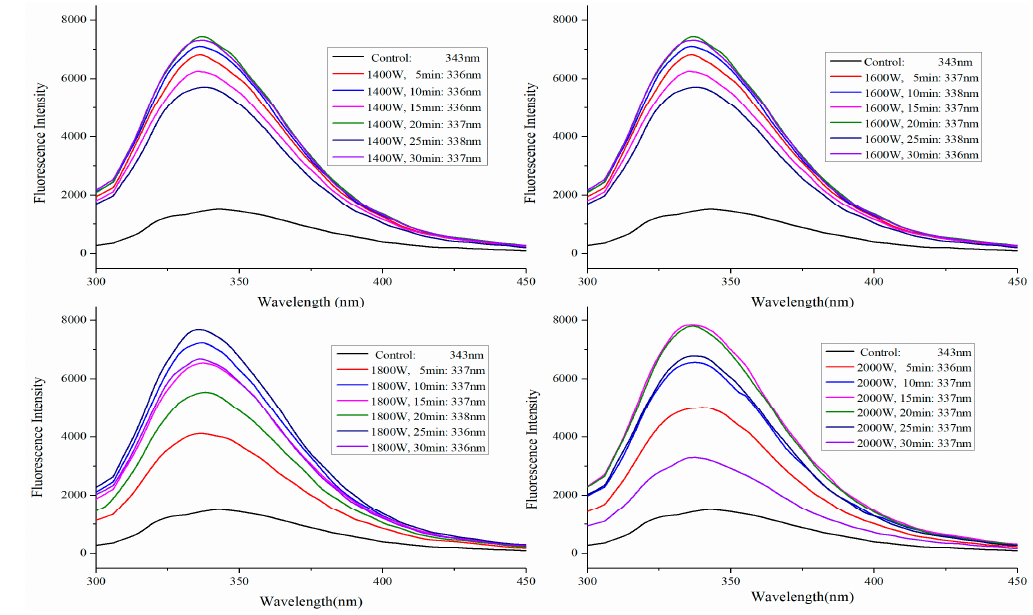
Figure 4. Fluorescence spectra of SPI after HIU treatment.